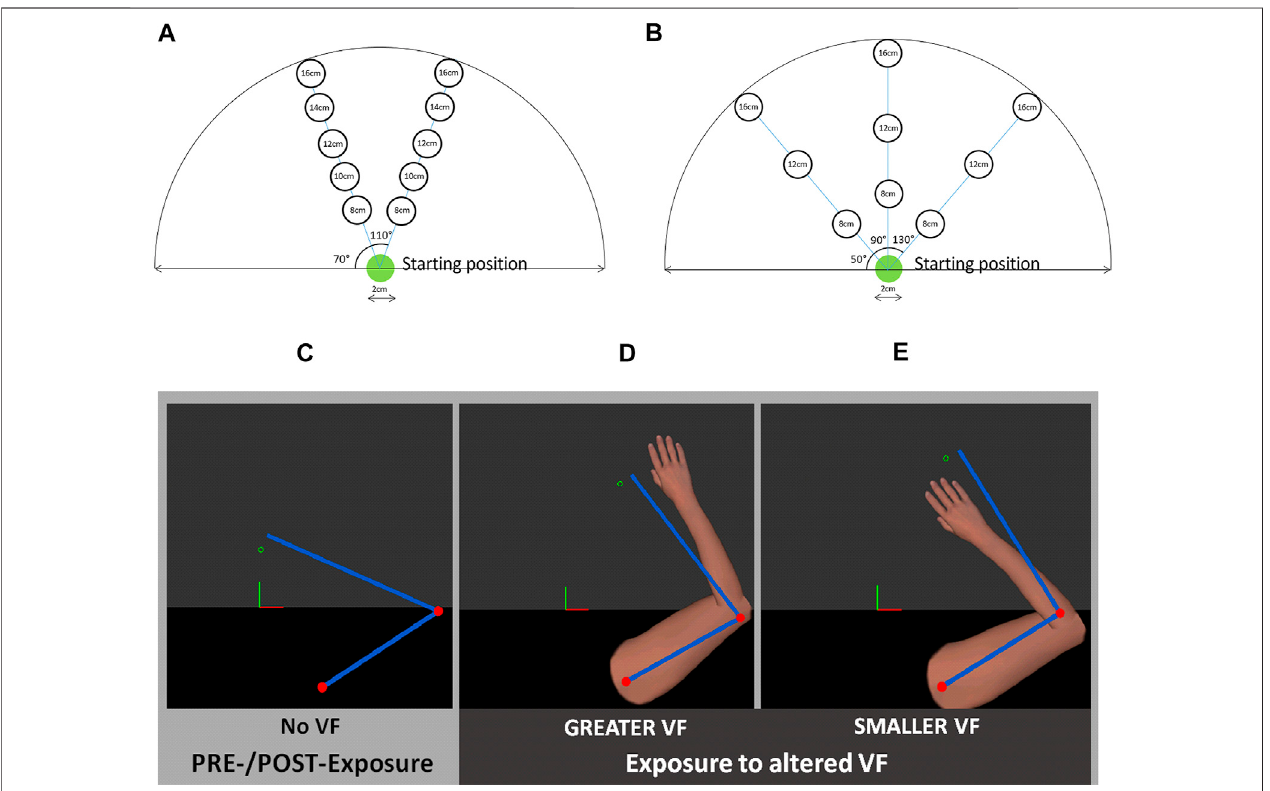
FIGURE 3 | Upper panel: Location of targets during (A) PRE- and POST-Exposure to altered visual feedback (VF) and (B) Exposure to altered VF. Lower Panel: Types of VF: PRE- and POST-exposure task, no VF was provided to the participants (C) ; during Exposure, virtual UL displayed GREATER (D) or SMALLER (E) movements than participant ’ s actual movements. Blue bars and red dots represent participant ’ s real UL and were only visible to the experimenter.